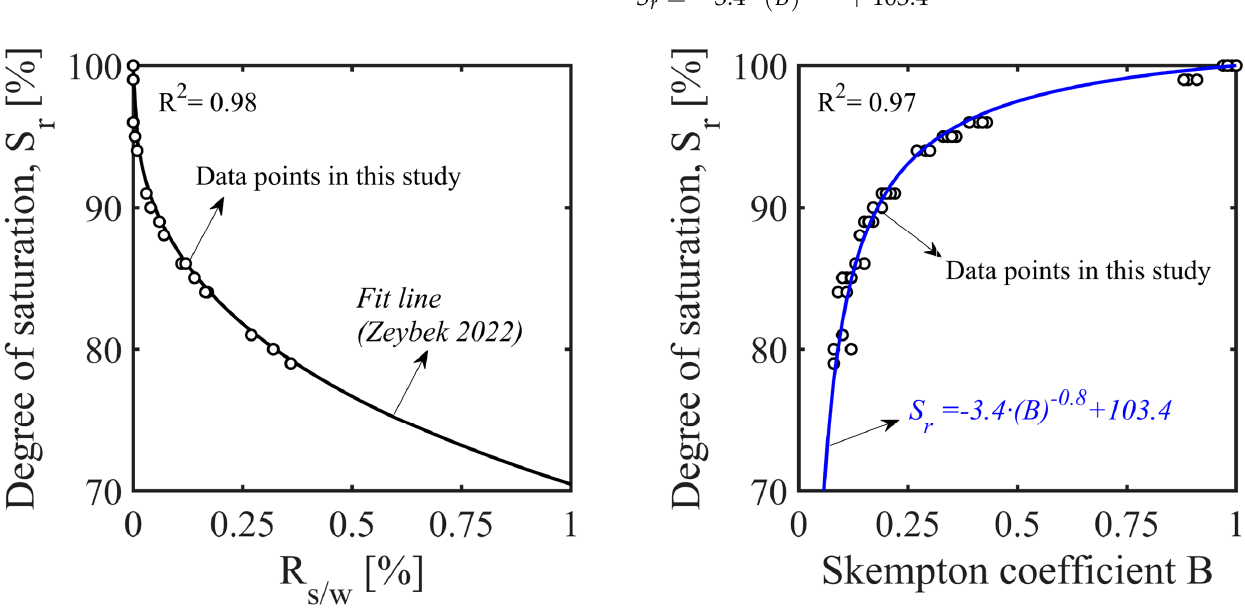
Figure 5. Relationship between the degree of saturation S r and Skempton’s pore-pressure parameter B .